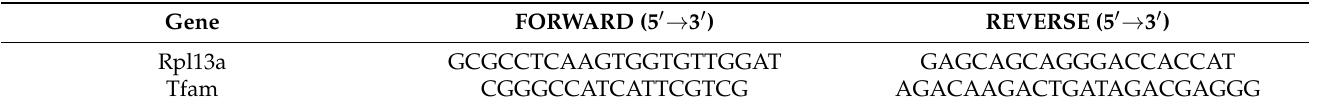
Table 1. Primers used for gene expression analysis.